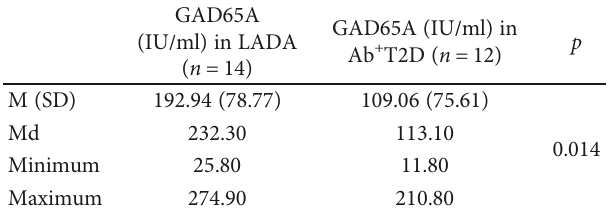
Table 1: Level of GAD65A in autoantibody-positive diabetic